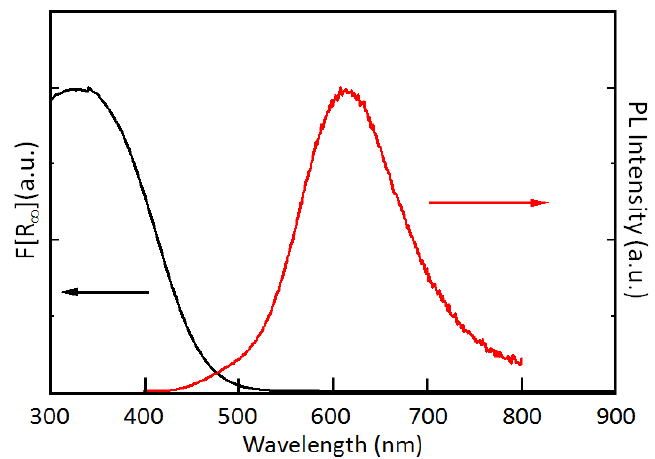
Figure 1. Photoluminescence (PL) and plots of F[R ∞ ] vs. wavelength for the powder form of the decane-terminated silicon quantum dot (SiQD-De) specimen. F[R ∞ ] of the powder form is the Kubelka−Munk function, with F[R ∞ ] = (1 − R ∞ ) 2 /2R ∞